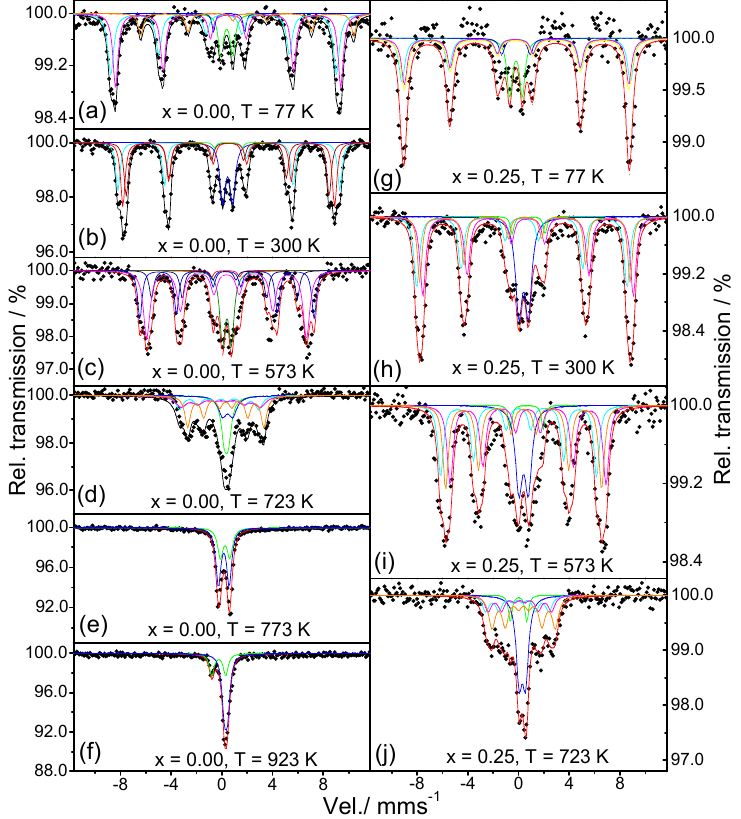
Figure 4. Mössbauer spectra for Sr 1 − x Ba x FeO 2 F: ( a – f ) x = 0.00 and ( g – j ) x = 0.25.